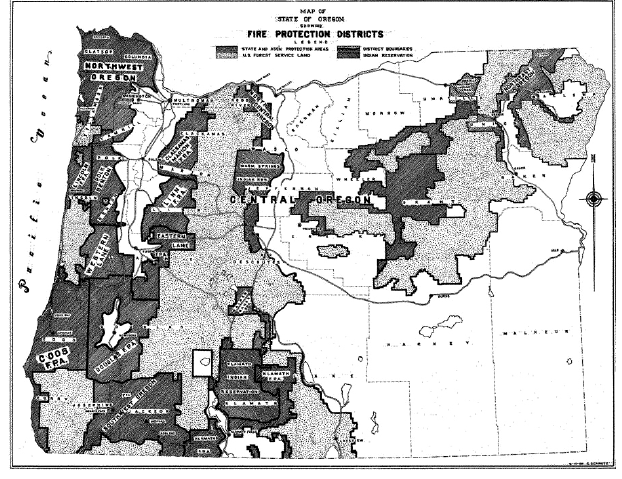
Fig. 3. Example representation of private corporate